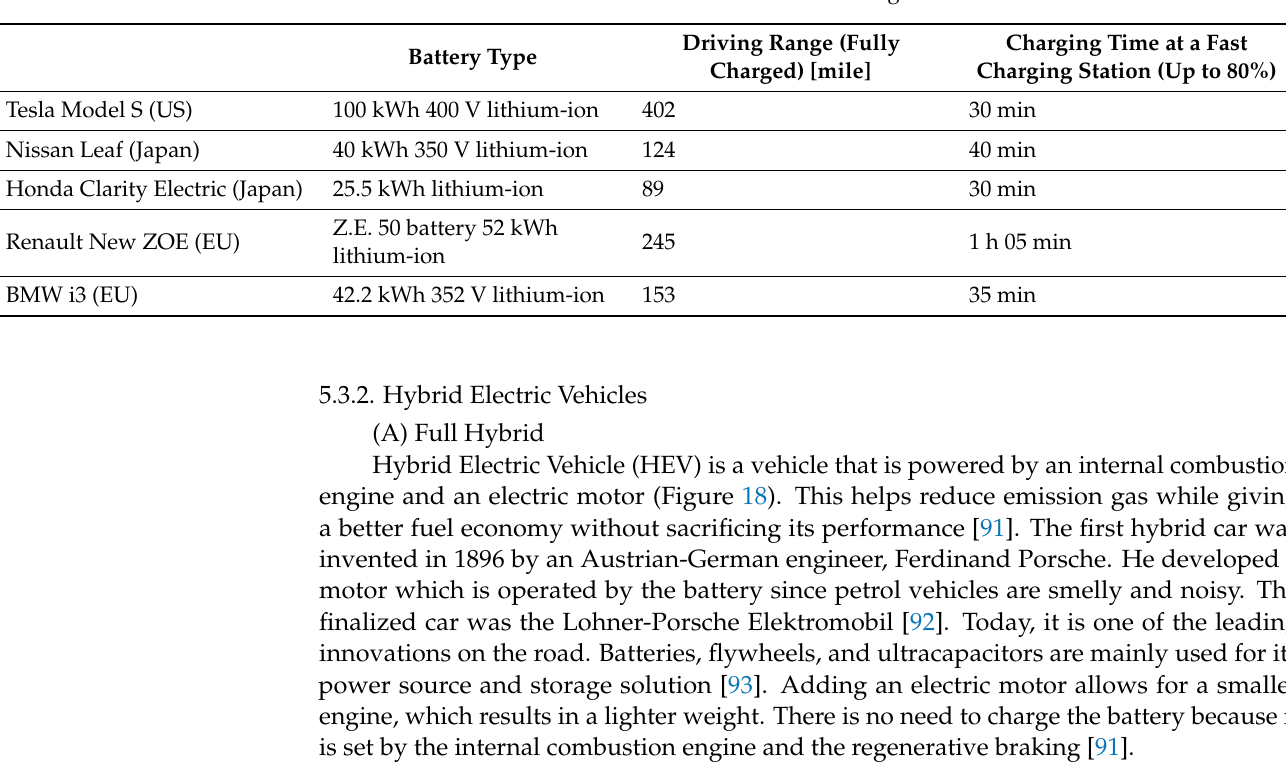
Table 4. The essential characteristics of various BEV engines.